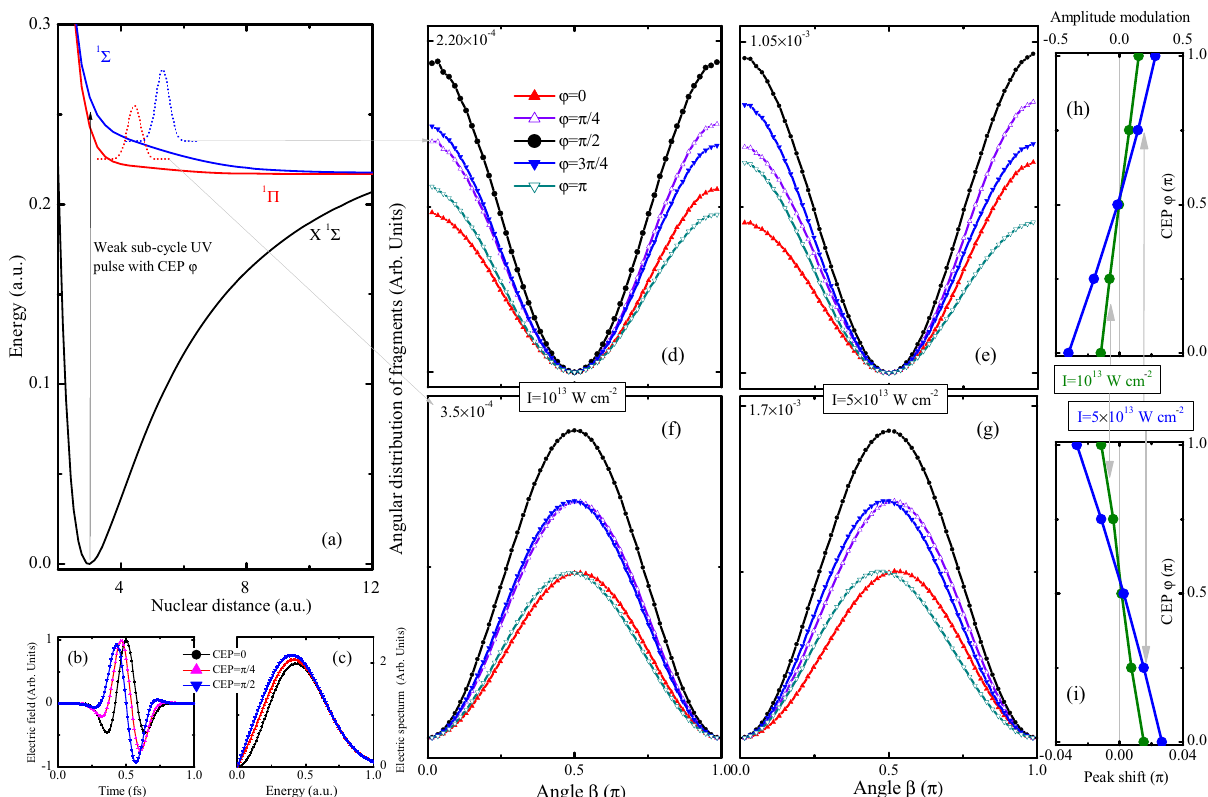
Fig. 1 Carrier-envelope-phase dependent angular distribution of photofragments. a Potential energy curves of LiF and the illustration of direct one- photon photodissociation by a sub-femtosecond pulse (central frequency ω = 7.07 eV and fwhm of 0.22 fs); time and energy dependence of electric fi eld for different CEP are shown in ( b ) and ( c ), respectively; ( d – g ) dependence of the angular distribution of photofragments (integrated over kinetic energy) on CEP and the fi eld intensity for A 1 Σ ( d , e ) and B 1 Π ( f , g ) excited states. The pro fi les for CEP = π /2 coincide well with cos 2 β or sin 2 β function for Σ and Π state, respectively. CEP-dependent amplitude modulation and peak shift for ( d , e ) and ( f , g ) are shown in ( h ) and ( i ),